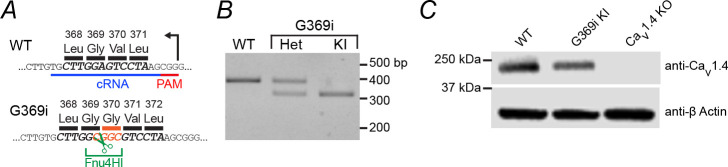
Characterization of the G369i KI mouse line.(A) CRISPR-Cas9 genome editing was used to insert a glycine residue between G369 and V370. The restriction site recognized by the endonuclease Fnu4HI was included in the repair template for genotyping. PAM, protospacer adjacent motif. cRNA, CRISPR RNA. (B) Gel image of PCR products that were amplified from genomic DNA followed by Fnu4HI digestion. Following digestion, two DNA fragments of ~330 base pairs (bp) and 60 bp (not shown) are present if the G369i mutation and Fnu4HI restriction site are within the CACNA1F gene. Note: the CACNA1F gene lies on the X chromosome, which precludes male mice from being heterozygous for the G369i mutation. (C) Western blot analysis of whole retina lysates collected from WT, G369i KI and Cav1.4 KO mice. Blots were probed with antibodies against Cav1.4 and β-actin. Bands corresponding to Cav1.4 were present in WT and G369i KI retina lysates, but not lysates from Cav1.4 KO mice.